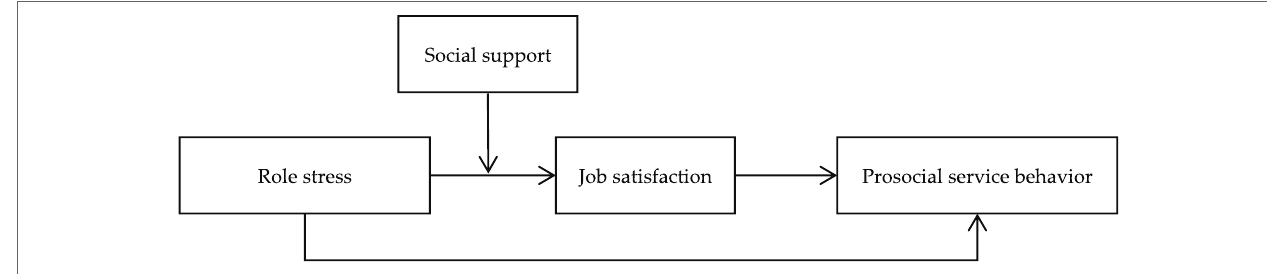
FIGURE 1 | The proposed moderated mediation